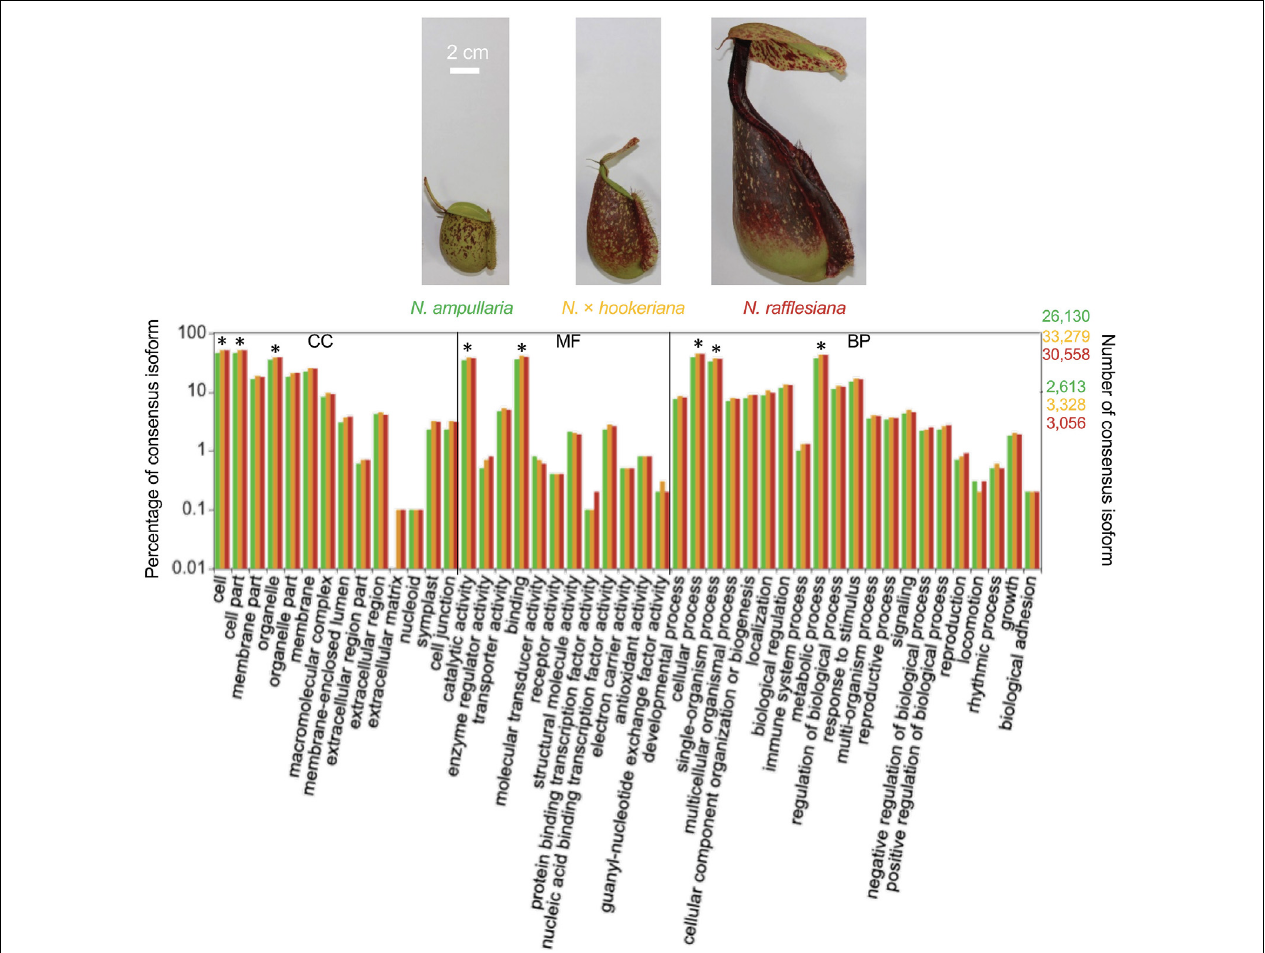
FIGURE 1 | The distribution of Gene Ontology (GO) terms of annotated consensus isoforms from all three Nepenthes species using WEGO based on cellular component (CC), molecular function (MF), and biological process (BP). Asterisks ( ∗ ) represent significant ( P < 0.001) differences in Pearson Chi-Square test. The bar chart is color-coded according to the font colors. Photos of the pitcher samples from the three species are displayed above with the same